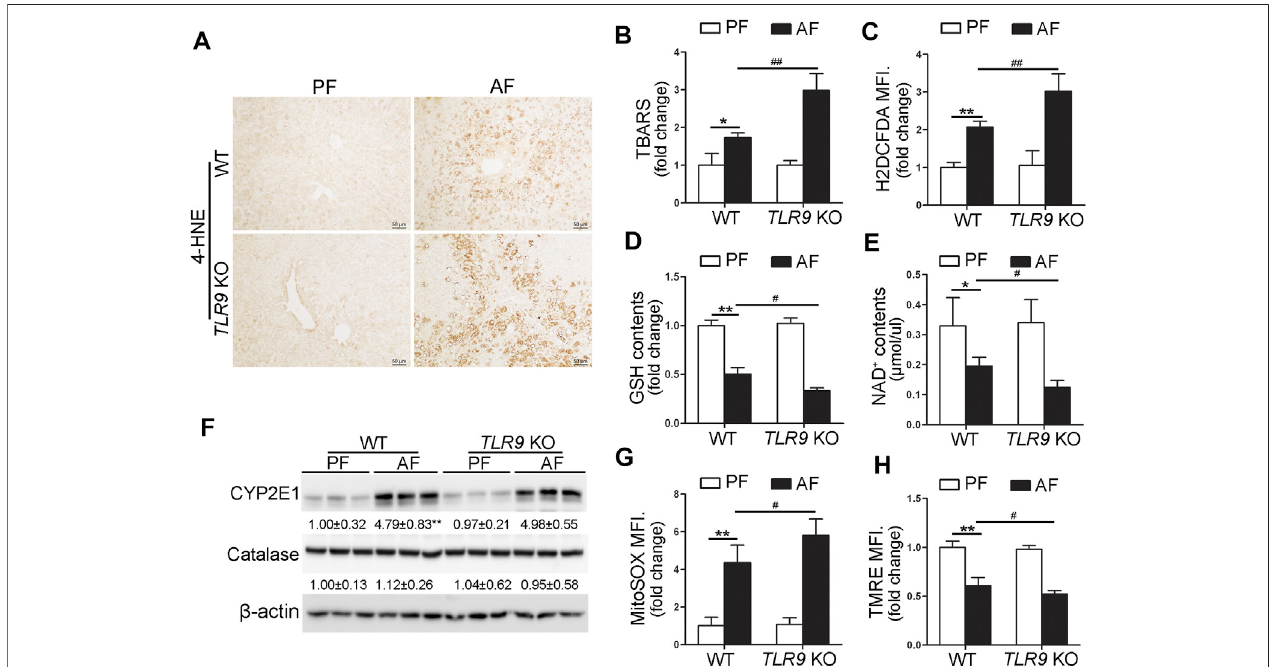
FIGURE 3 | Alcohol-induced oxidative stress and mitochondrial dysfunction were exacerbated in TLR9 KO mice. TLR9 KO and wild-type male mice were pair-fed or alcohol-fed for 8 weeks plus a single binge of ethanol (4 g/kg) before 4 h of tissue collection. (A) Immunohistochemistry analysis of hepatic 4-HNE expression. Scale bars:50 μ m. (B) HepaticTBARSlevels. (C) FACSanalysisofhepatictotalROSusingH2DCFDAdye.Dataarethesummaryofthemean fl uorescenceintensity(MFI). (D) Hepatic GSH levels. (E) Hepatic NAD + levels. (F) Western bolt analysis of hepatic CYP2E1 and catalase. (G) FACS analysis of hepatic mitochondrial ROS using MitoSOX dye ( n (cid:2) 5). (H) FACS analysis of hepatic mitochondrial membrane potential using TMRE dye (n (cid:2) 5). Data are the summary of the mean fl uorescence intensity (MFI). Data are presented as means ± SD. * p < 0.05, ** p < 0.01 vs. WT/PF mice; # p < 0.05, ## p < 0.01 vs. WT/AF mice. PF, pair-fed; AF,